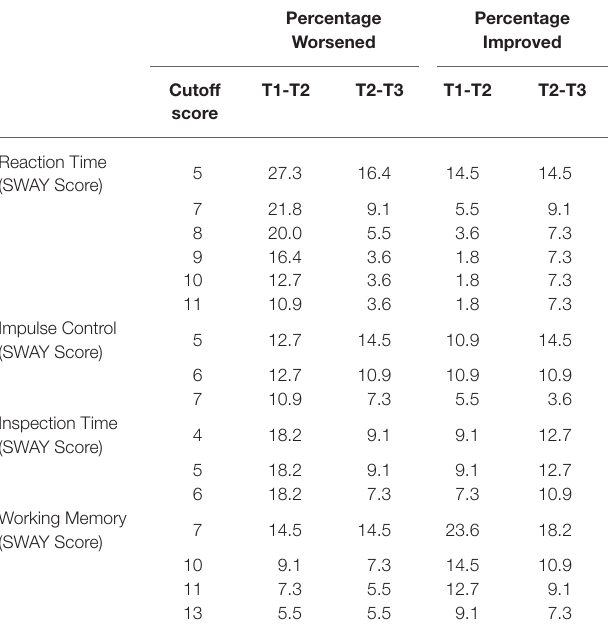
TABLE 7 | Cutoffs for interpreting